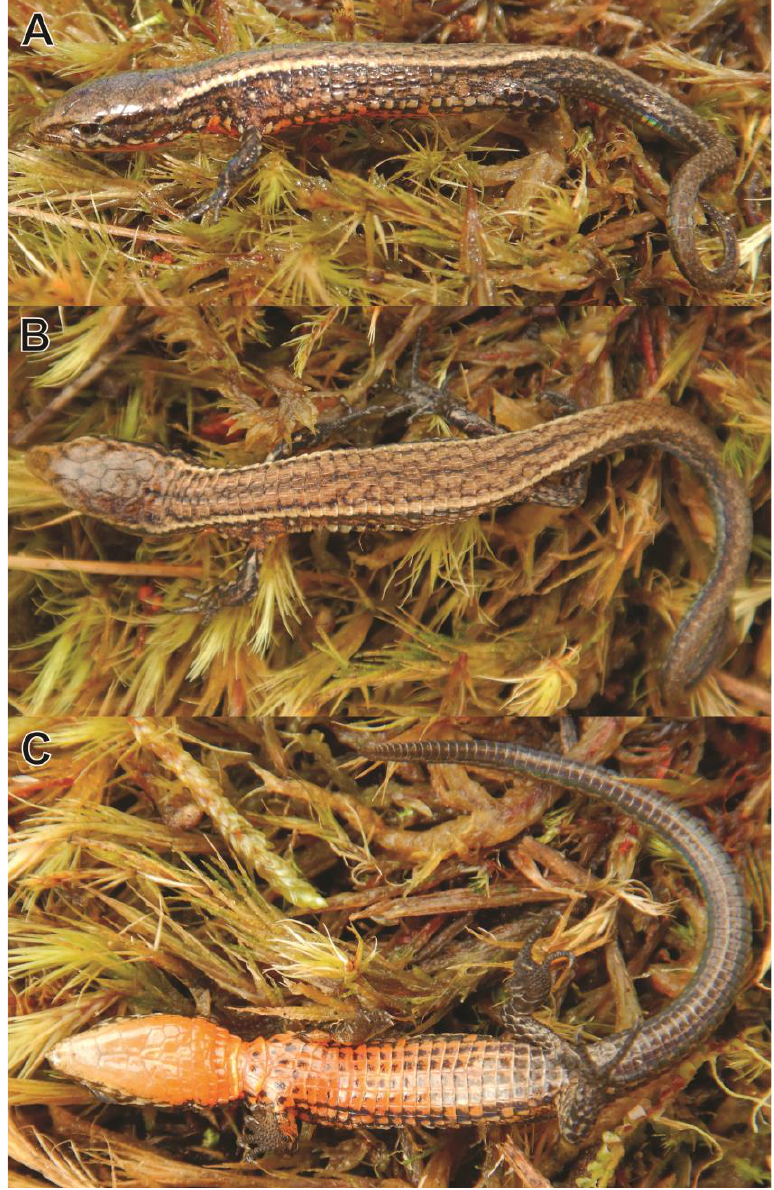
Figure 8. Life hatchling (MUSM 40918, male paratype) of Proctoporus titans sp. nov. in dorsolateral ( A ), dorsal ( B ), and ventral views ( C ). SVL 22.9 mm. Diagnosis:(1) Frontonasal equal in size or longer than frontal; (2) nasoloreal suture Comparisons: Proctoporus titans sp. nov., P. laudahnae , P. machupicchu , and P. unsaacae incomplete or absent; (3) three supraoculars, the anteriormost supraocular fused with the have four anterior supralabials. However, P. titans sp. nov. and P. laudahnae have dorsal anteriormost superciliary; (4) four superciliaries, the anteriormost superciliary fused with scales striated, but P. laudahnae is larger (max SVL 65.0 vs. 53.9 mm) and females have the anteriormost supraocular; (5) two postoculars; (6) palpebral disc undivided and trans- 6–7 femoral pores (absent), [19,38]. Proctoporus titans sp. nov. and P. machupicchu both parent; (7) three to five supralabials anterior to the posteroventral angle of the subocular; have the venter black or dark gray but P. machupicchu has a loreal scale present (absent), (8) four to six anterior infralabials; (9) two pairs of genials in medial contact (rarely one or three pairs of genials in medial contact (one to two, rarely three), limbs overlapping (not three); (10) three (rarely four) rows of pregulars; (11) dorsal body scales, rectangular, stri- overlapping), and first supraocular not fused with first supraciliary (fused), [20]. All ated (two centrally positioned, parallel and longitudinal distinct furrows), and subimbri- examined specimens of Proctoporus titans sp. nov. have dorsal scales striated, whereas P. unsaacae have dorsal scales keeled and sometimes striated, but P. unsaacae has a loreal cate; (12) 34 – 40 scales around the midbody; (13) 33 – 41 transverse dorsal rows; (14) 19 – 23 scale present (absent), nasal divided (undivided), and femoral pores in females present transverse ventral rows; (15) 20 – 25 longitudinal dorsal rows; (16) 10 – 12 longitudinal ven- or absent (absent), [23]. Five anterior supralabials are present in P. bolivianus , P. carabaya tral rows; (17) a continuous series of small lateral scales separating the dorsals from the ventrals; (18) two anterior preanal plate scales; (19) two to six posterior cloacal plate scales; (20) five to seven femoral pores per hind limb in males, absent in females; (21) preanal